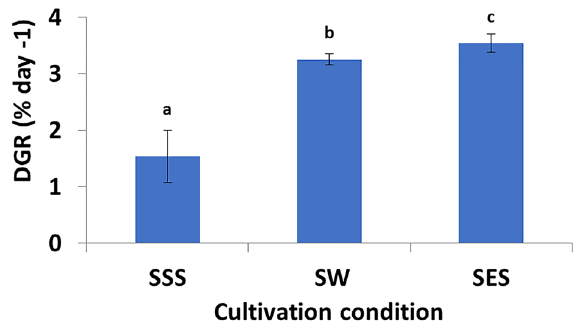
Figure 3. Daily growth rate (DGR, % day −1 ) of Gracilaria gracilis expressed as average ± standard deviation (SD). (a) Sulfur starved seawater (SSS), (b) seawater (SW), and (c) sulfur enriched seawater (SES). Sulfate concentrations [SO 42− ] of the treatments were 2.5 mM, 27 mM and 50 mM for SSS, SW, and SES, respectively; (n = 3).